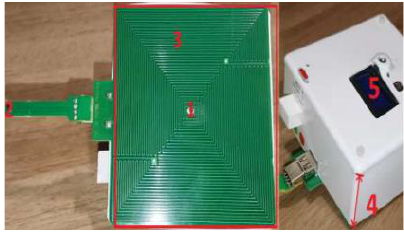
Figure 14. Components of a rapid U-value meter. Reproduced from Pekkala